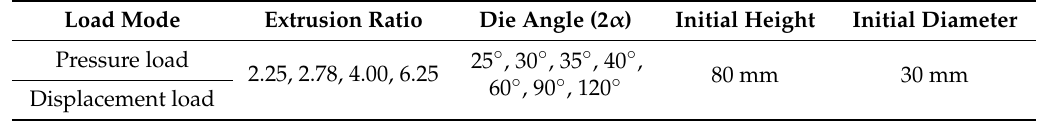
Table 2. Simulation parameters of pressure load mode and displacement load mode.